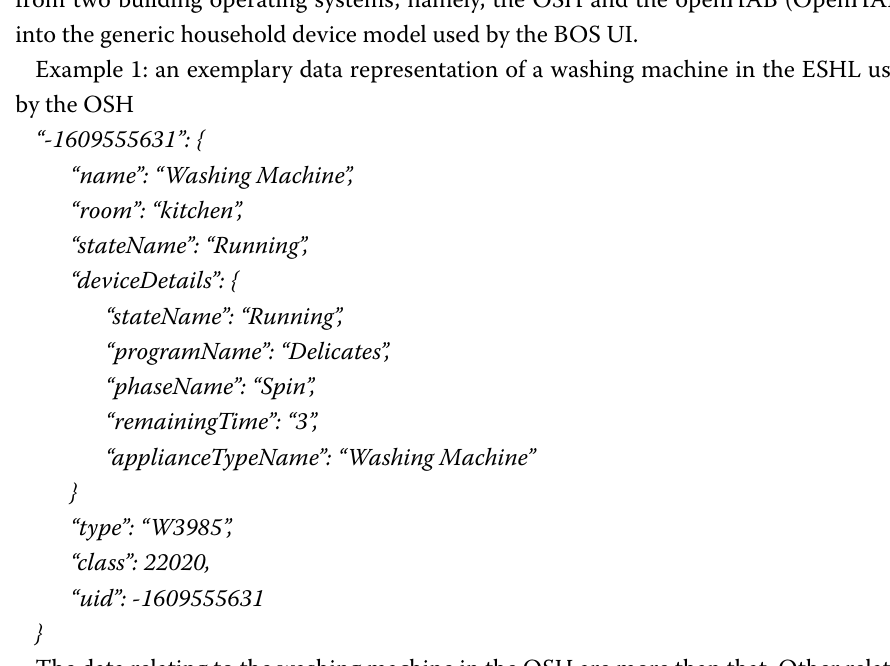
Example 1: an exemplary data representation of a washing machine in the ESHL used by the